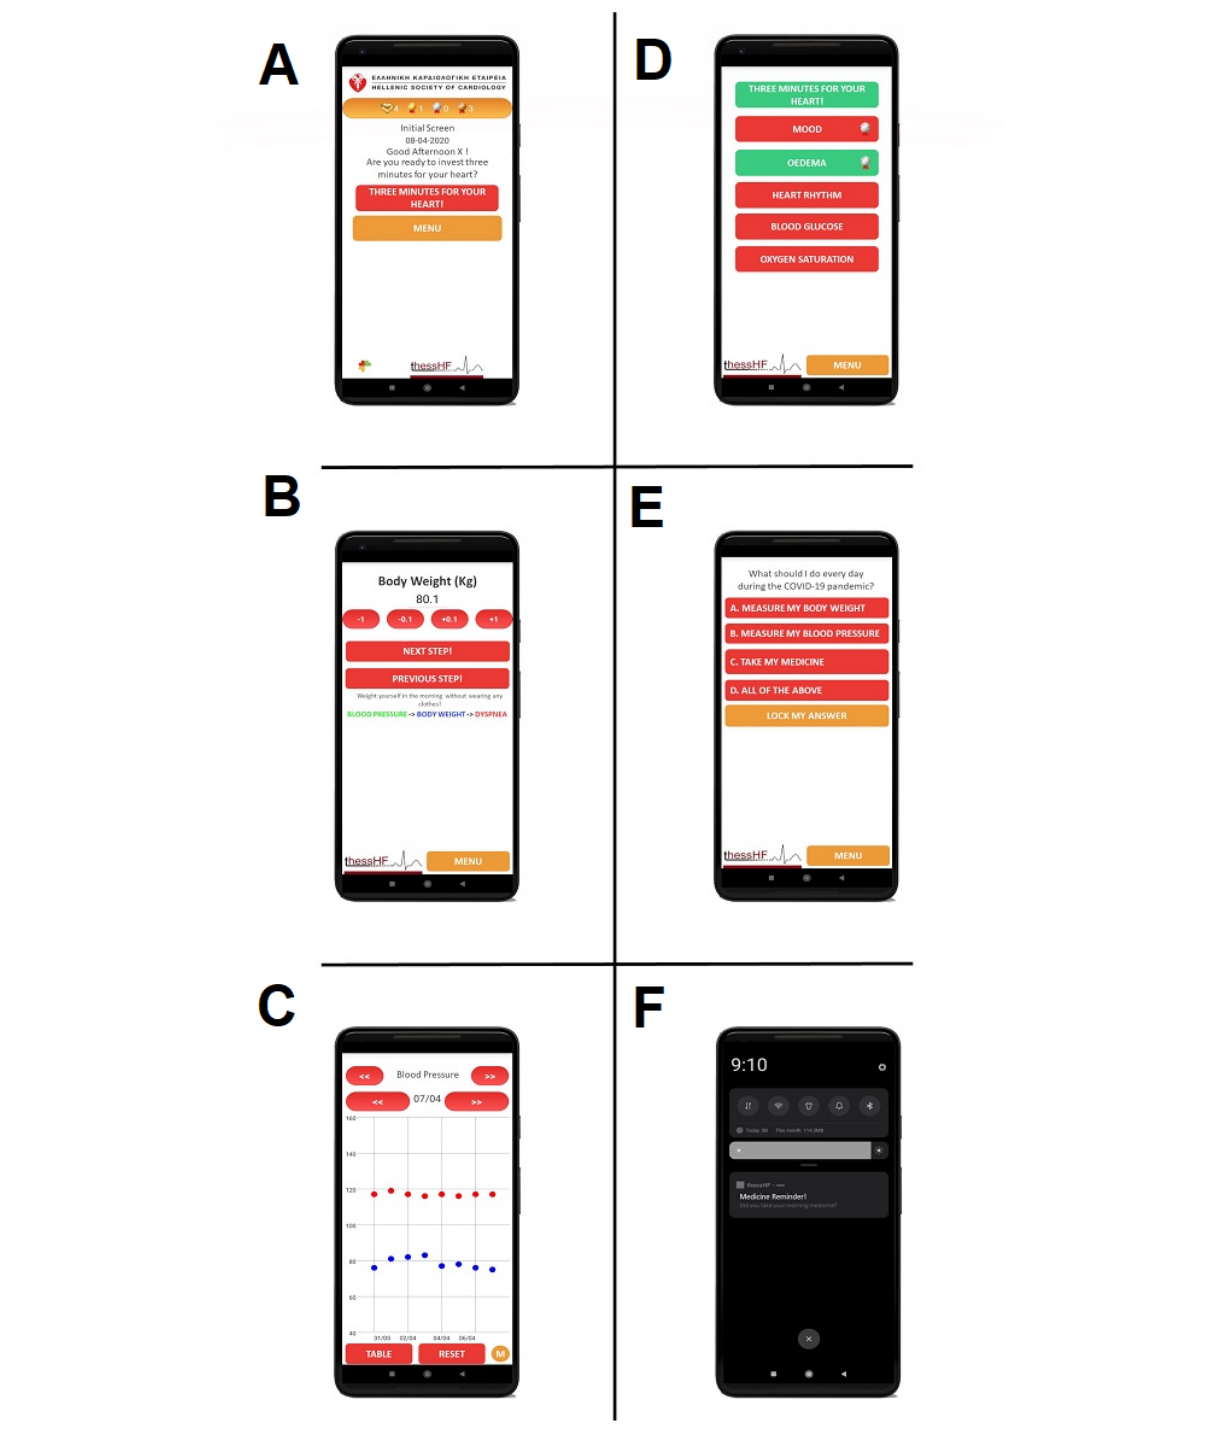
Figure 2. Screenshots of the ThessHF app translated in English, displaying (A) the main screen and gamification features, (B) the activity where patients input their blood pressure, (C) history of blood pressure available as a graph, (D) the main menu screen, where inputted parameters turn green, (E) a question out of the weekly quiz, and (F) the push notification reminding patients to take their